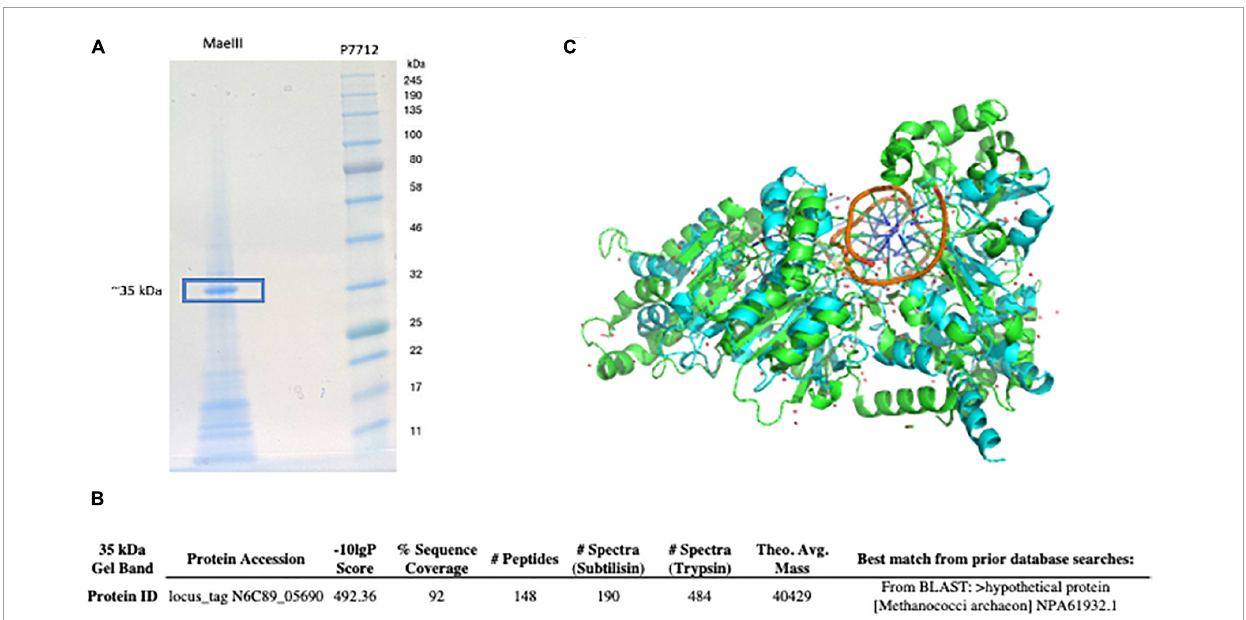
FIGURE4 Mae III restriction endonuclease separated on 10–20% Tris-Glycine SDS-PAGE and stained with SimplyBlue SafeStain. The protein band at ∼ 35 kD was excised and used for MS/MS analysis (A) . The sequence matched locus_tag N6C89_05690 from the M. aeolicus PL15/H p genome was detected by MS/MS analysis as putative Mae III restriction enzyme (B) . M. aeolicus PL15/H p assembled genome was scanned for additional DNA methyltransferase genes using an automated implementation of HMMer, which produced another potential hit corresponding to locus_tag N6C89_5685. The predicted structure of the M. Mae III protein through AlphaFold2 monomeric modeling (C) . The best scoring match to an AlphaFold2 predicted model of N6C89_5685 locus was 7lt5, the PDB structure of CamA, an adenine methyltransferase of Clostridioides difficile (Zhou et al.,